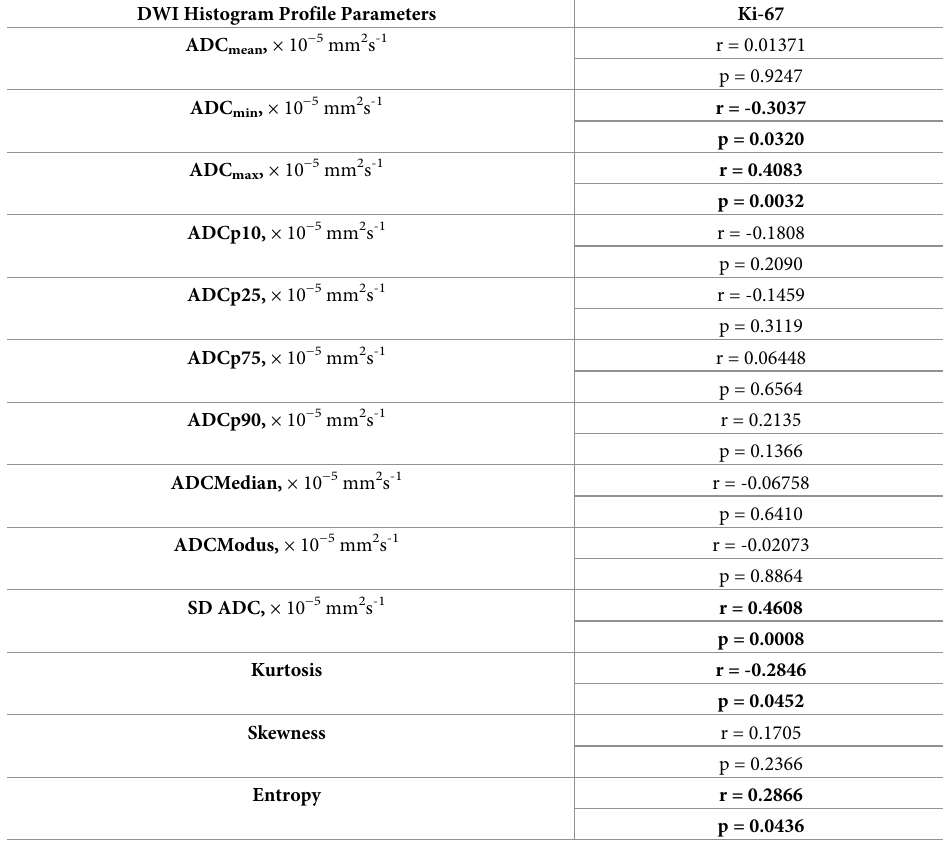
Table 4. Correlations between DWI histogram profile parameters and Ki-67 in all investigated gliomas.